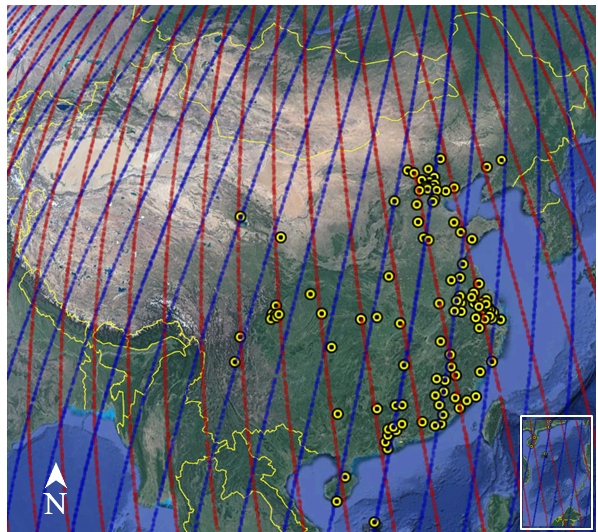
Figure 1. Geographic distribution of RWP sites and Aeolus ground tracks superimposed on a Google Earth map of China (© Google Maps). Red and blue lines represent the Aeolus ground tracks for ascending and descending orbits, respectively. The yellow dots de- note the RWP